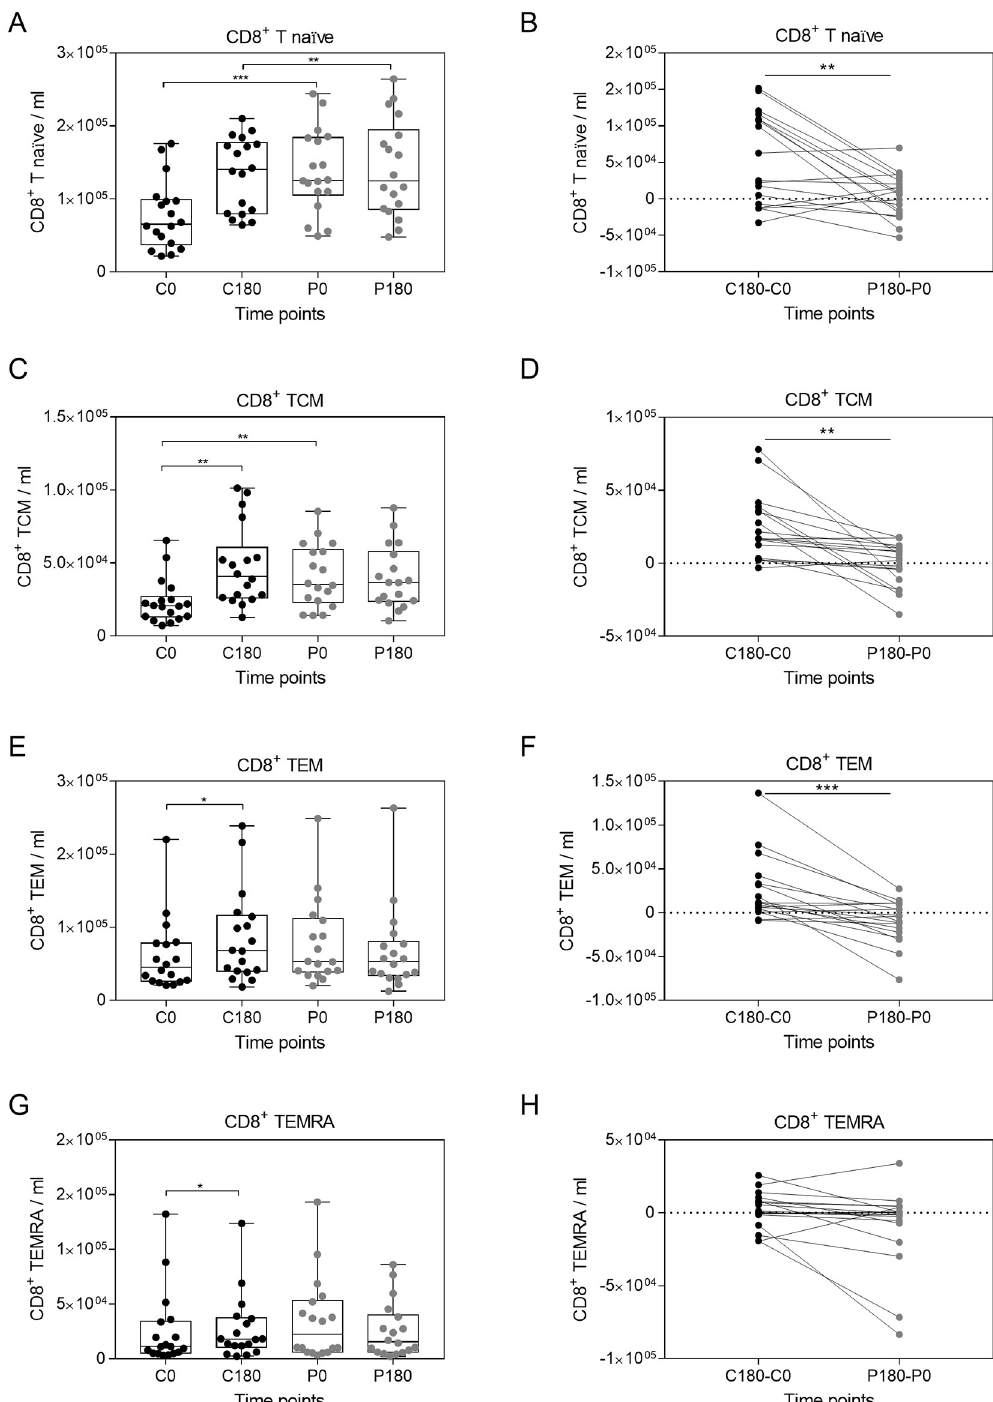
Fig 5. Na ï ve and memory CD8 + T cells are sensitive to gravitational stress. CD8 positive memory and na ï ve T cells were discriminated according to CD45RA and CCR7 expression (S5 Fig). Quantification of na ï ve CD8 + T cells (A) CD8 + TCM (C) and CD8 + TEM (E) cell number. The differences between the control period and the parabolic flight period were compared for na ï ve CD8 + T cells (B) CD8 + TCM (D) and CD8 + TEM (F). Asterisks indicate p-values ( ��� p < 0.01; �� p < 0.01; � p < 0.05) of the statistical